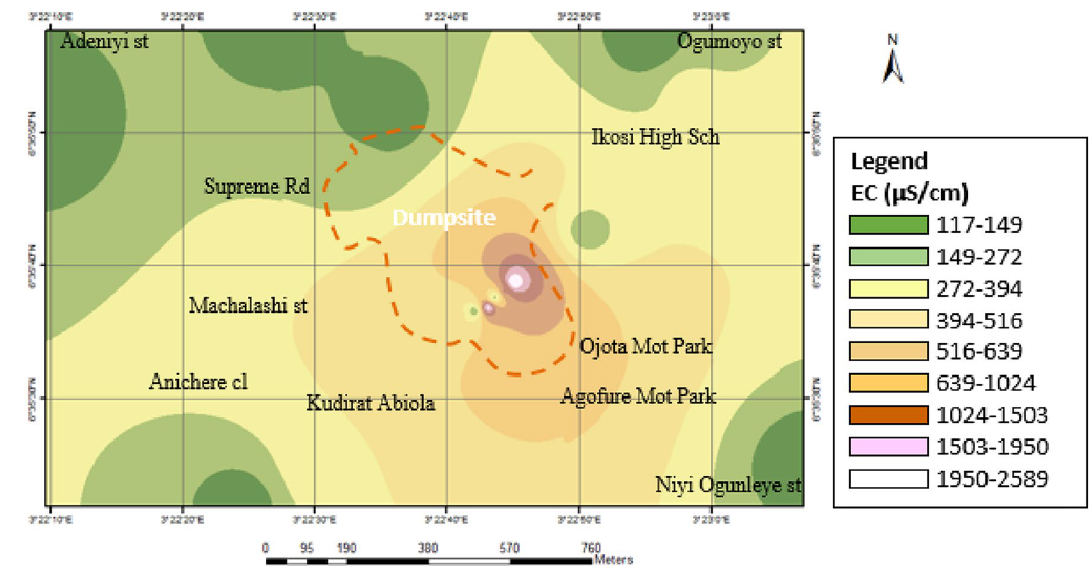
Fig. 10 Spatial distribution of electrical conductivity within the study